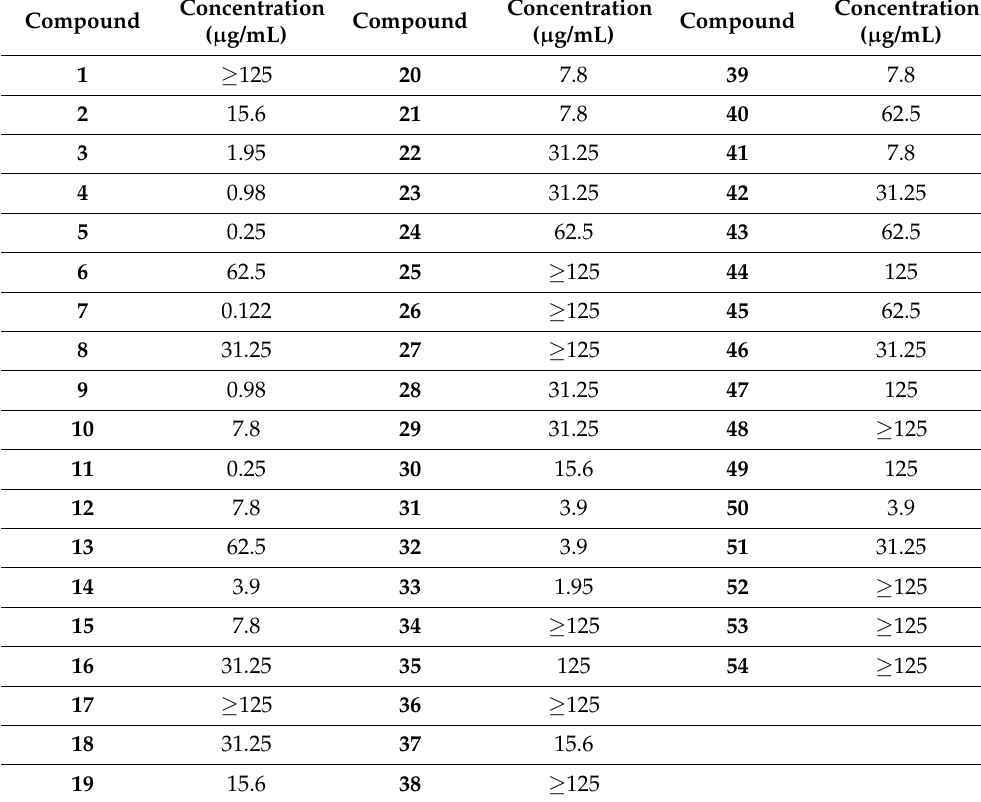
Table 1. Antifungal activity (MIC 90 ) of fifty-four nitrofuran and indole derivatives against the H. capsulatum EH-315 strain. Compound